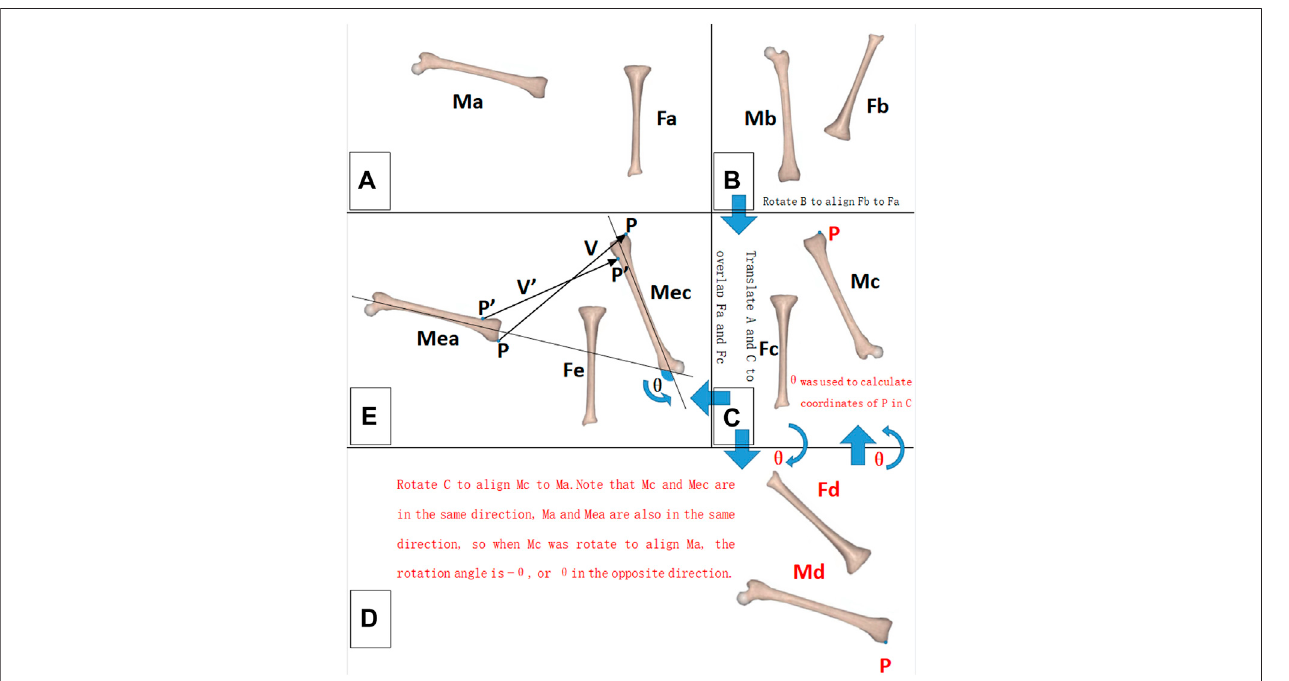
FIGURE 2 | Schematic diagram of the relative motion measurement. For a 2-dimensional rigid body, the black font part should be noted; for a 3-dimensional rigid body,theblackandredfontpartsshouldbenoted. (A) Initialstateoftherigidbodies. (B) Terminalstateoftherigidbodies. (C – E) Measurementprocess.M:movingrigid body. F: fi xed rigid body. P, P ′ : reference point. V, V ′ : displacement vector of the reference point. θ : rotation angle of the moving rigid body